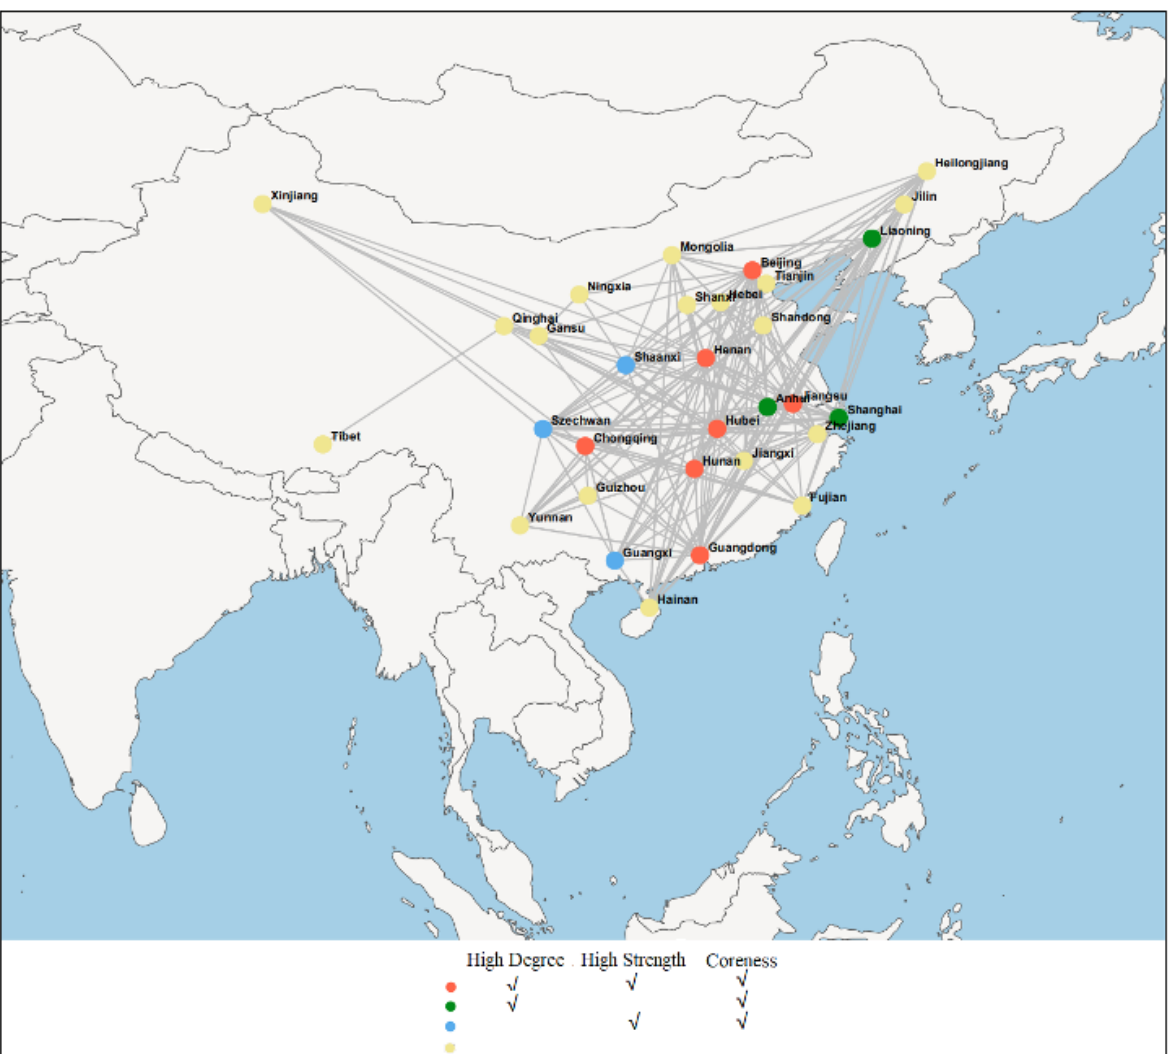
Figure 12. Topological image in geospatial space depicting the network relationship and the centrality of each node over the whole period. The colors of the nodes relate to the intensity of the degree, strength, and